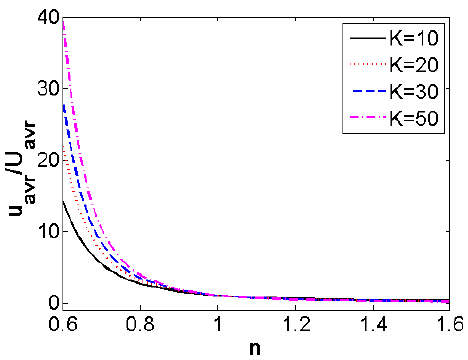
Figure 8. The variation of dimensionless average velocity generalized with the average velocity of Newtonian fluid ( n = 1) with flow behavior index n under the situation of different width ratio K ( ξ = − 4).